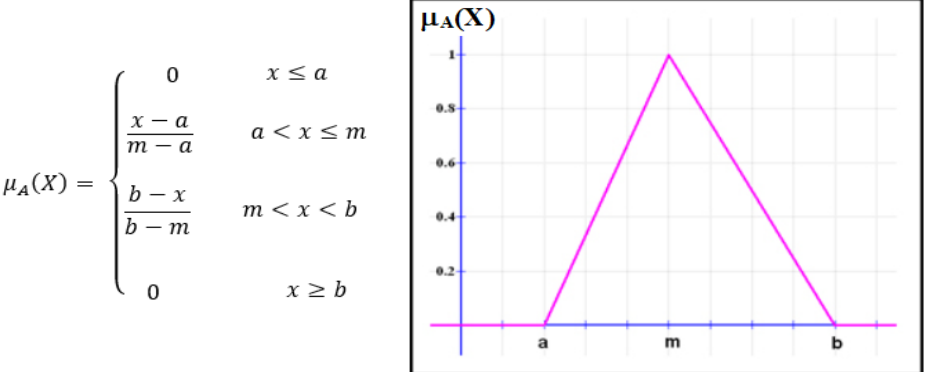
Figure 7. Fuzzy system membership function.